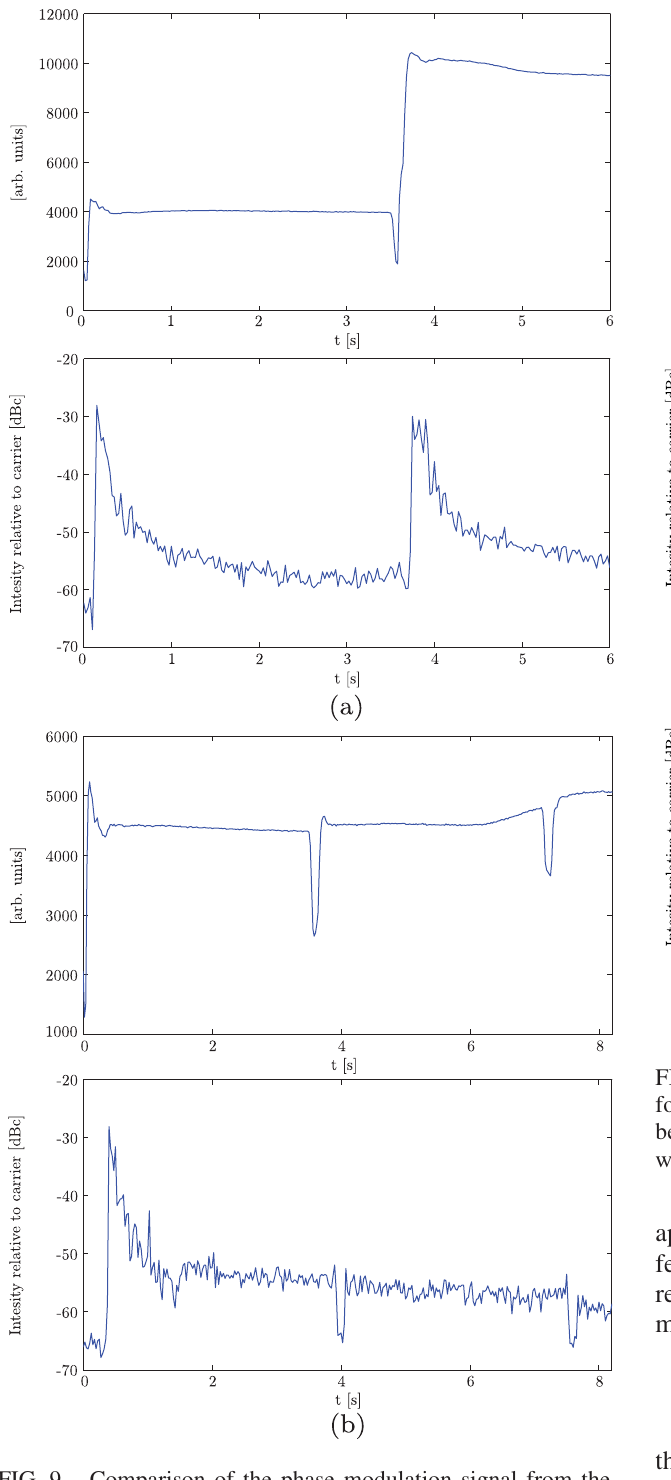
FIG. 9. Comparison of the phase modulation signal from the microwave transmission experiments [lower graph in (a) and (b)] to the electron cloud monitor readings [upper graph in (a) and (b)]. In (a), the data was taken with the nominal LHC 25 ns beam of four batches at SPS flat bottom. In (b), the data was taken with the nominal LHC 25 ns beam of one batch at SPS flat bottom. Dips in the signal are seen with both methods.